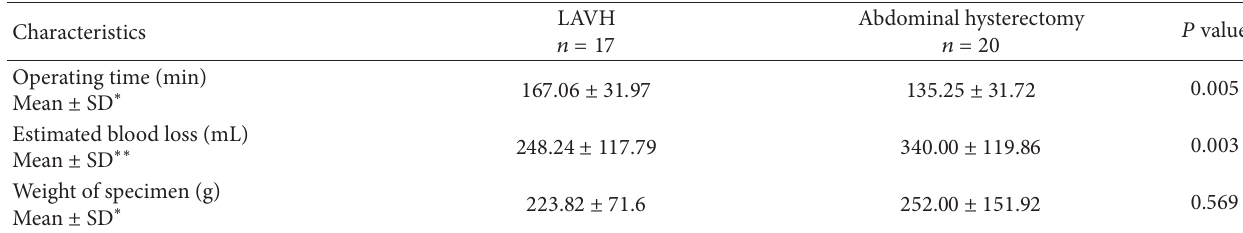
Table 2: Intraoperative characteristics.